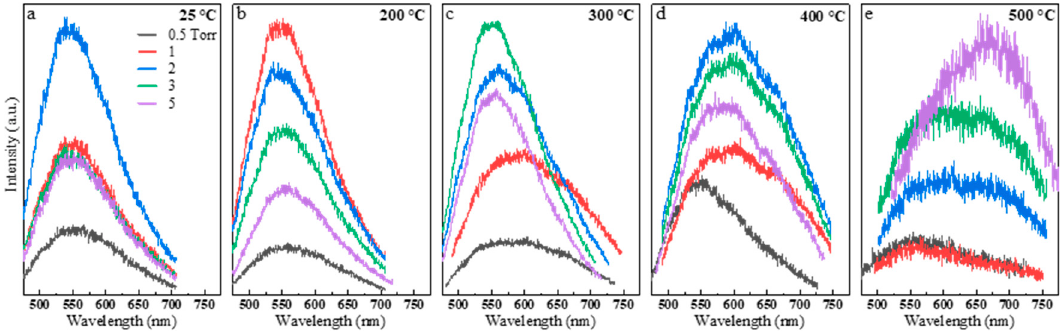
Figure 4. Photoluminescence (PL) spectra of the nanoparticles deposited at various pressure for the as-deposited case ( a ) and at the indicated baking temperatures ( b – e ). The sample deposited at 0.5 torr shows the weakest PL emission for all due to the formation of dense films (i.e., no nanoparticles). The PL spectra at 2, 3, and 5 torr have the maximum intensities due to the formation of nanoparticles.